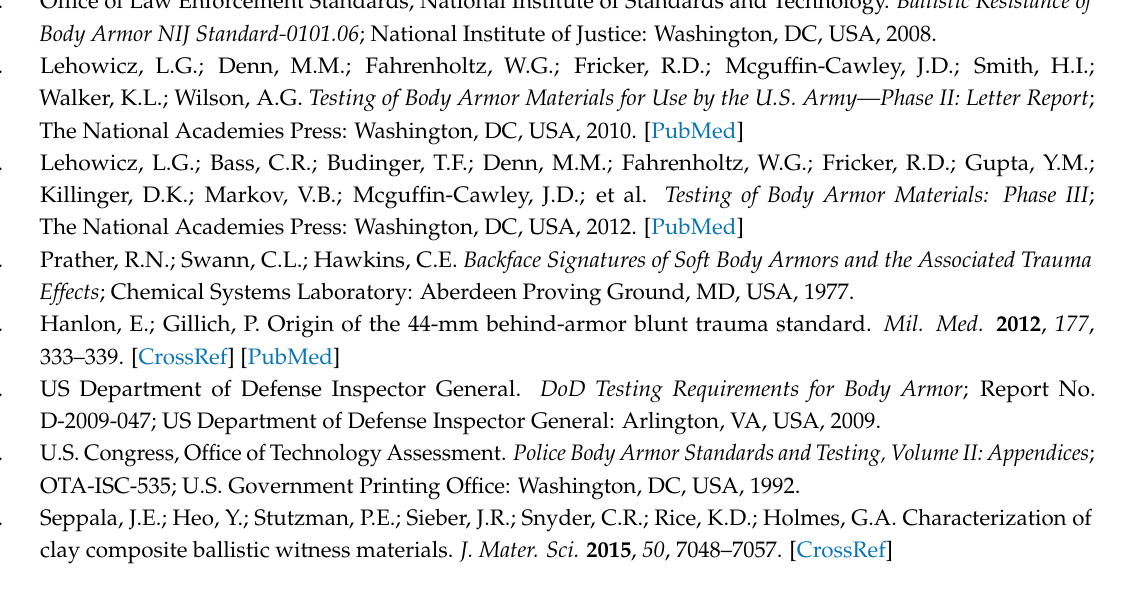
Figure S1: Dynamic shear loss modulus ( G ”) as a function of frequency, Figure S2: Reduced loss modulus ( G ”⁄ G 0 ”) as a function of strain amplitude at different frequencies, Figure S3: Last cycle of raw LAOS data for the SCBMs and the RP1 clay, shown as Lissajous − Bowditch loops of normalized stress versus normalized strain within the Pipkin space of frequency and strain